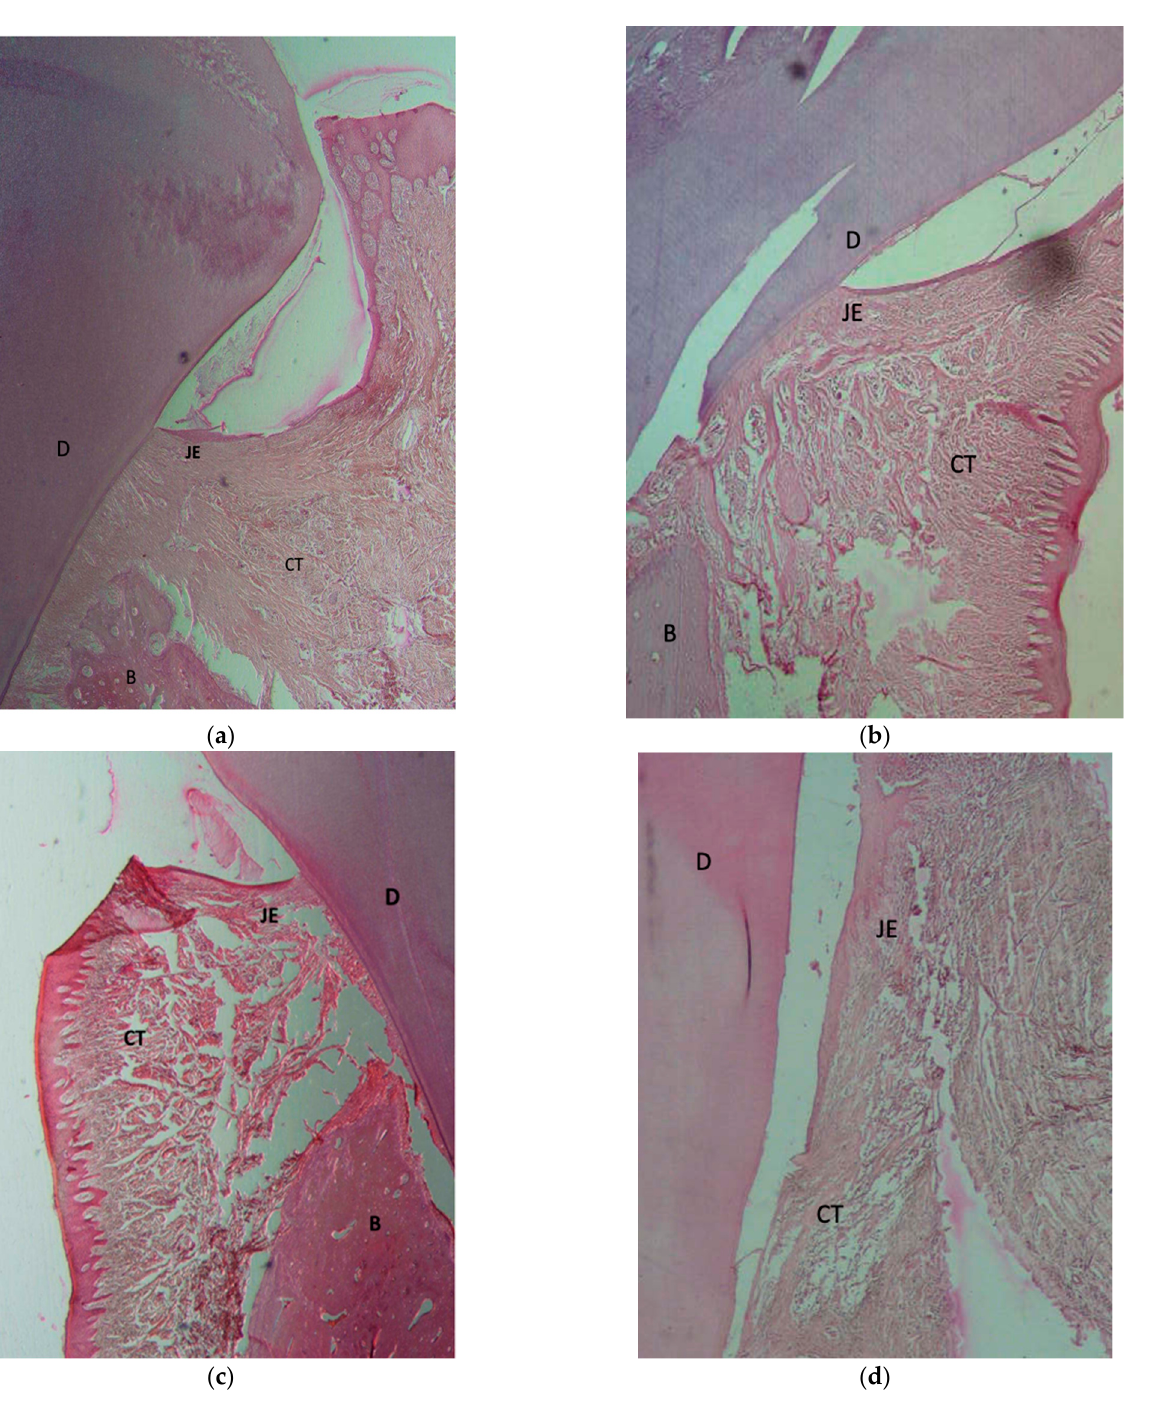
Figure 4. Histomorphometric views of the bucco–lingual section of the critical-size surgically cre- ated periodontal defect sites of specimens 8 weeks after interventions. The defect site (5 mm below CEJ) was investigated in all samples. GTR sample treated with ( a ) Botiss—Jason membrane, ( b ) Regedent—Smartbrane membrane, ( c ) 3D-printed membrane. In specimens treated by the GTR technique plus placement of a membrane, there were signs of regeneration of the defect with bone formation, new connective tissue attachment, and formation of a junctional epithelium. ( d ) Con- trol/without membrane. In the control samples, the defect was only filled with long junctional epi- thelium and CT due to the faster growth rate of the epithelial fibroblasts. (GTR: guided tissue re- generation, B: bone; D: dentin; CT: connective tissue; JE: junctional epithelium). However, in the control group samples (Figure 4d), only long junctional epithelium and highly vascularized connective tissue were observed on the denuded root surfaces in